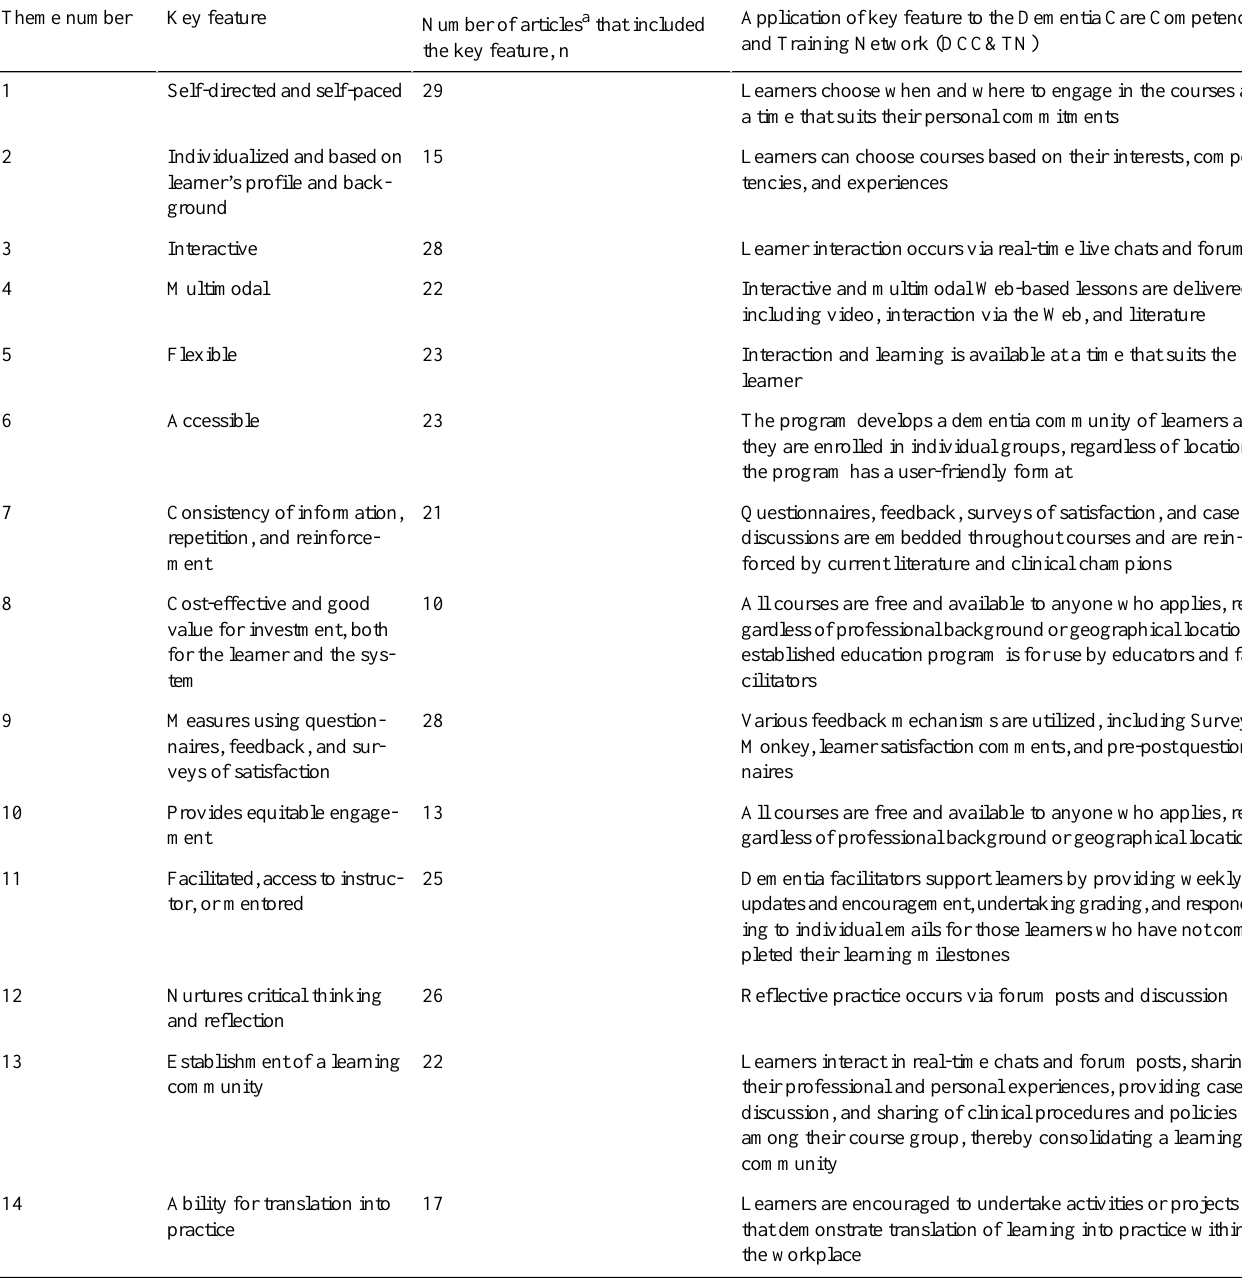
Table 1. Thematic analysis of the literature identifying key features for effective and functional online learning.